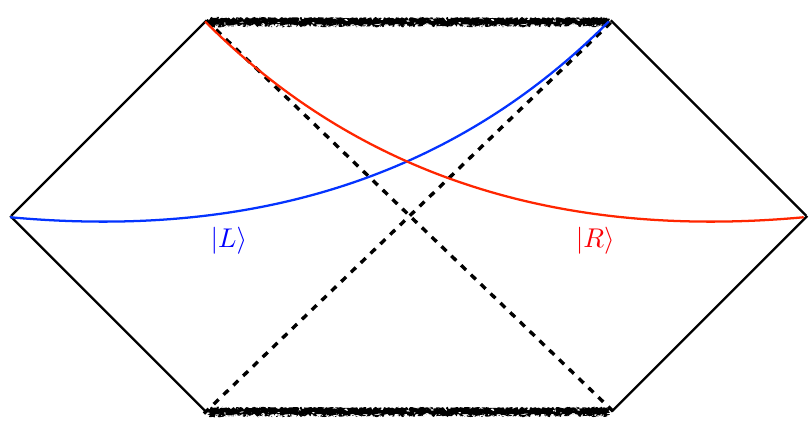
Figure 8 . L and R sectors correspond to wave functions on the two complementary spatial j i j i slices in the two-sided black hole interpretation of the zigzag